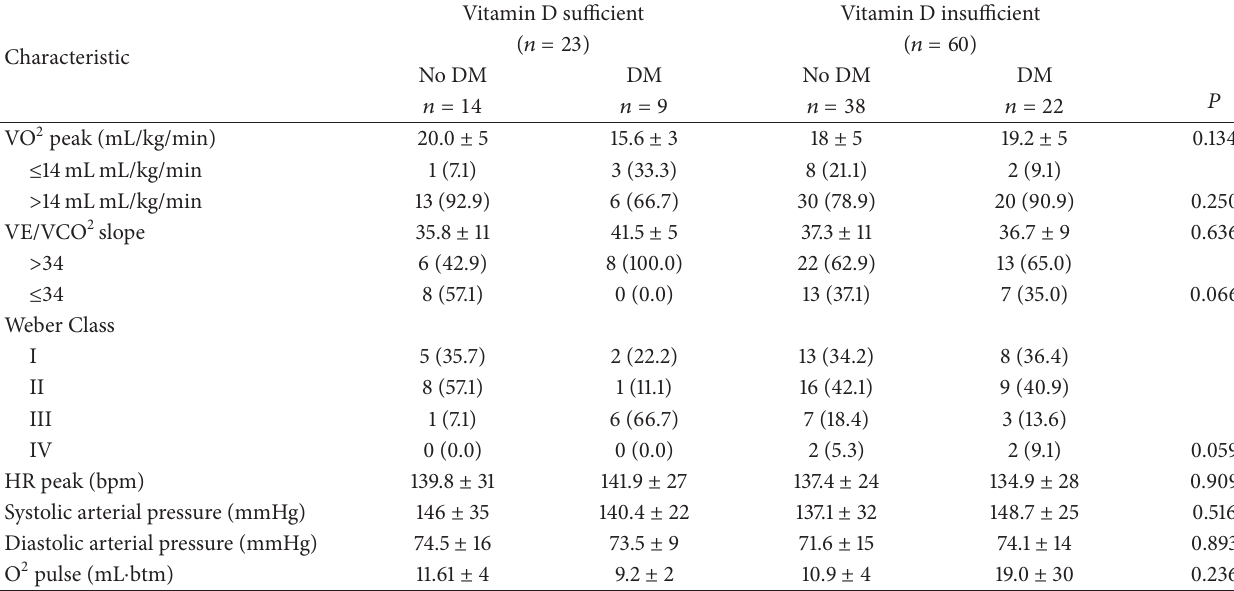
Table 4: Cardiopulmonary exercise test-metabolic and ventilatory characteristics according to vitamin D and diabetes mellitus. Vitamin D Characteristic